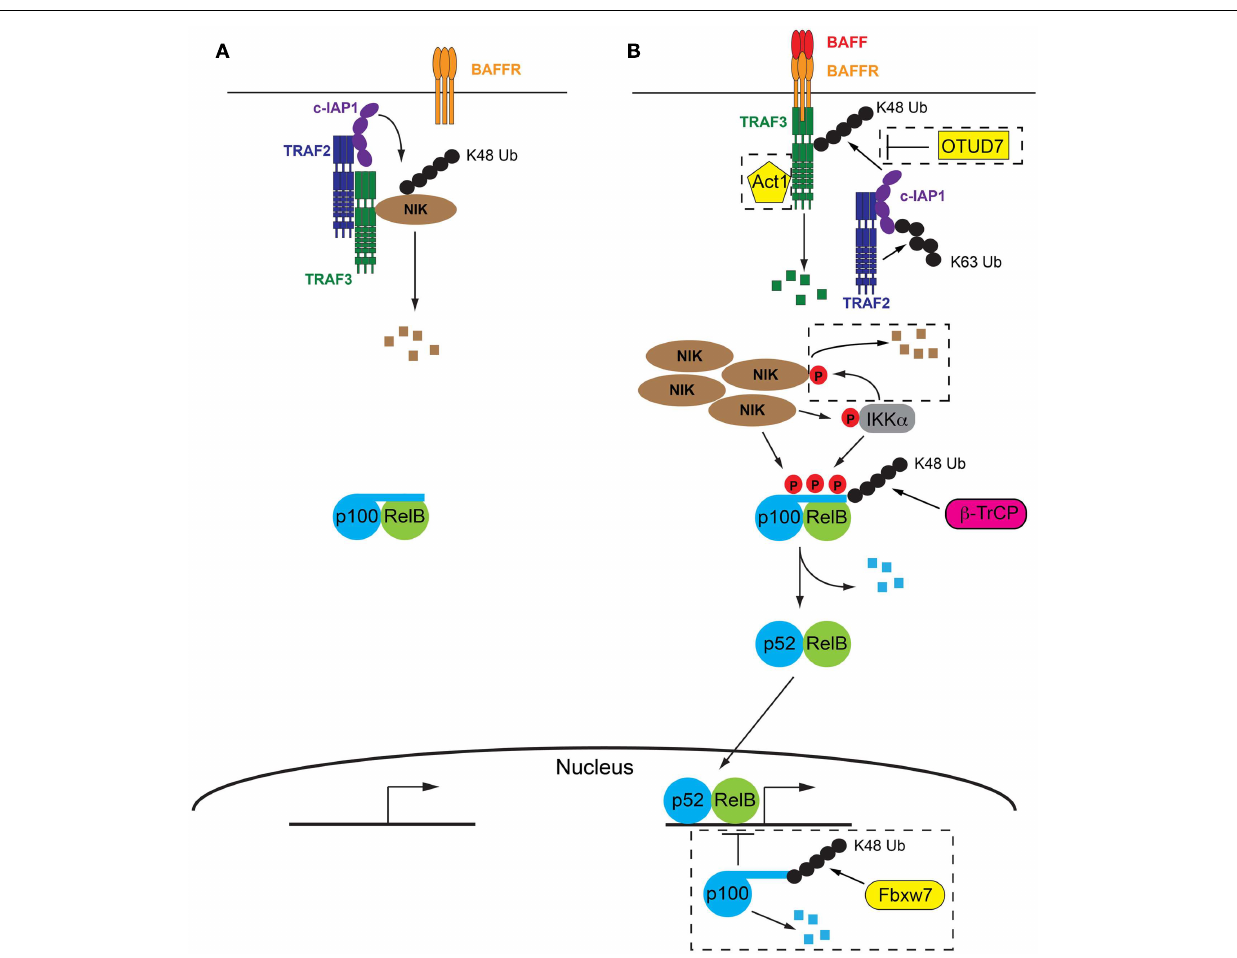
IKK α . p100 is subsequently partially degraded and active p52/RelB dimers are able to migrate to the nucleus and initiate NF- κ B2 specific